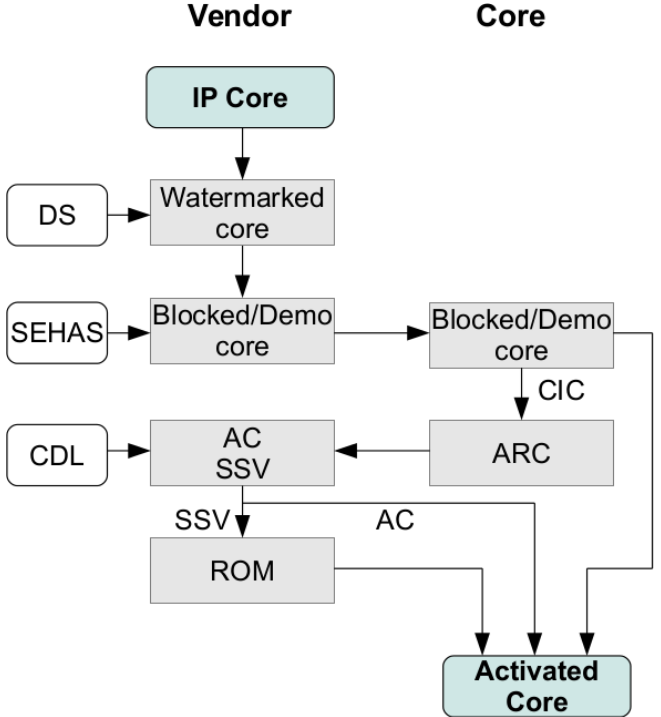
Figure 1. Flow diagram for the hardware activation